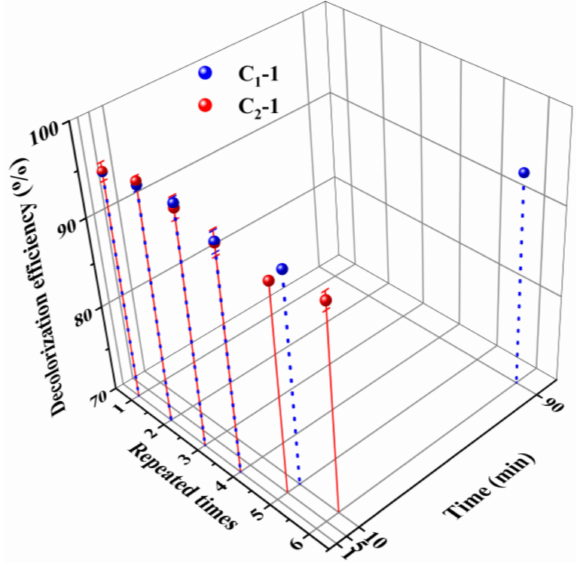
Figure 5. The performance of the fiber to decolorize MB aqueous solution during its repeated application; the fibers C 1 -1 and C 2 -1 are described in Section 2.4.